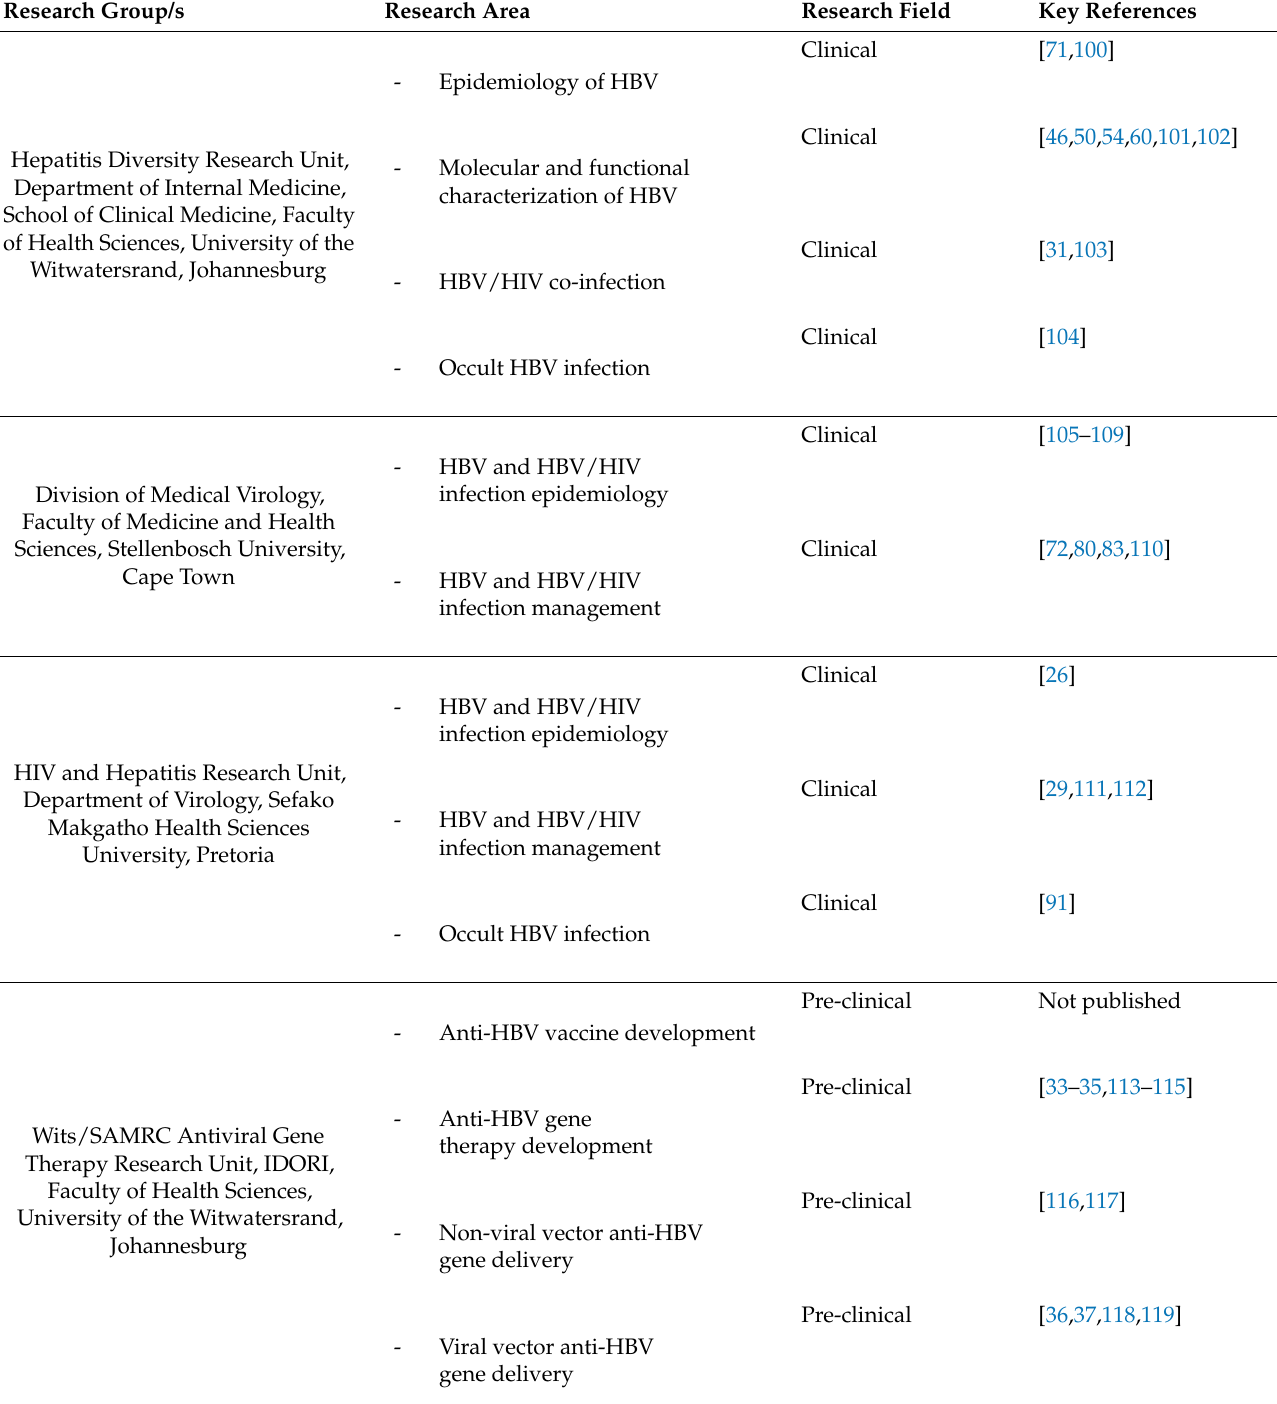
Table 2. Key areas of HBV research in South